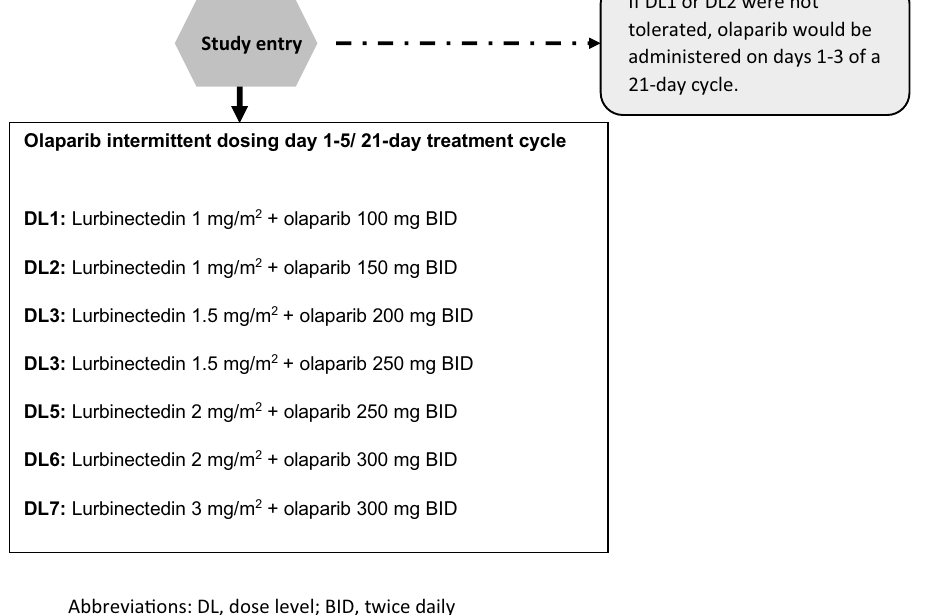
Figure 1. The 3 + 3 dose-escalation study